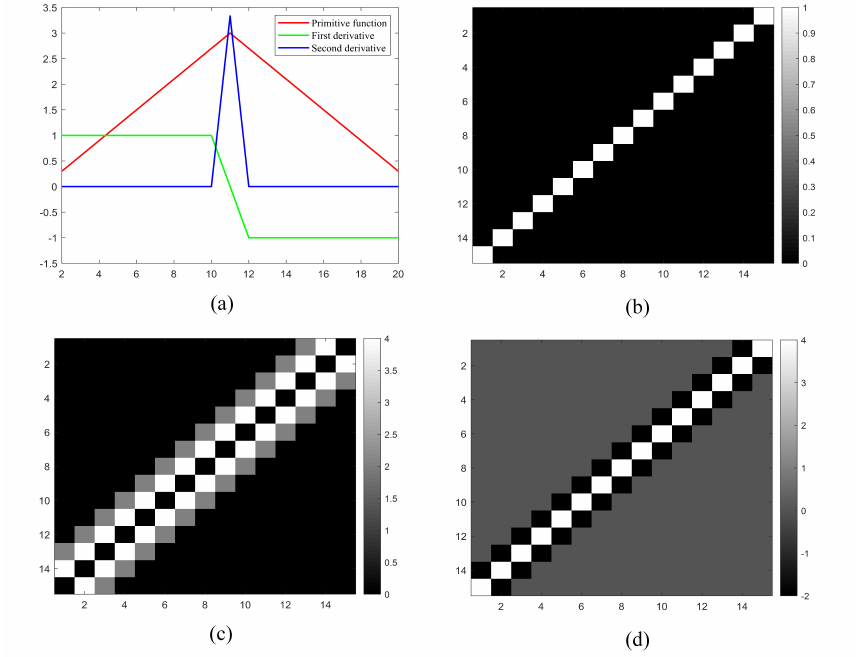
Figure 4. Ridge detection in relation to edge detection. ( a ) Difference between the first derivative and second derivative. ( b ) Simulated ridge. ( c ) Edge detection. ( d ) Ridge